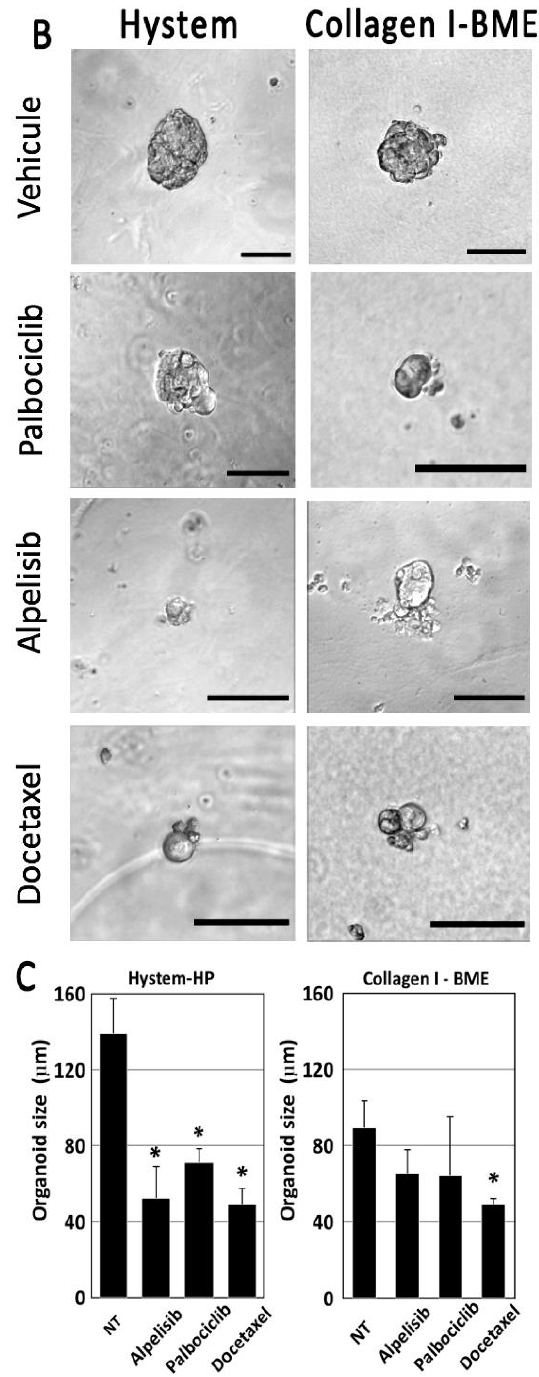
Figure 5. Primary tumor cells from patients were dissociated, reaggregated and cultured in Hystem-HP or collagen I/BME mixed hydrogel. Dissociated tumor cells were able to reaggregate in suspension, forming heterogeneous spheroids expressing both CK5 and CK8 ( A ). When cultured in Hystem-HP, aggregates grew slowly, but maintained their viability and phenotype over several weeks. They were sensitive to drug treatment, showing signs of cell death and reduced aggregate size as calculated from 35 spheroids ( B , C ). The Hystem-HP substrate was more favorable to tumor cell growth in this tumor. Scale bar: 100 µ m. * for p < 0.05 in a Student T test comparing treated with untreated